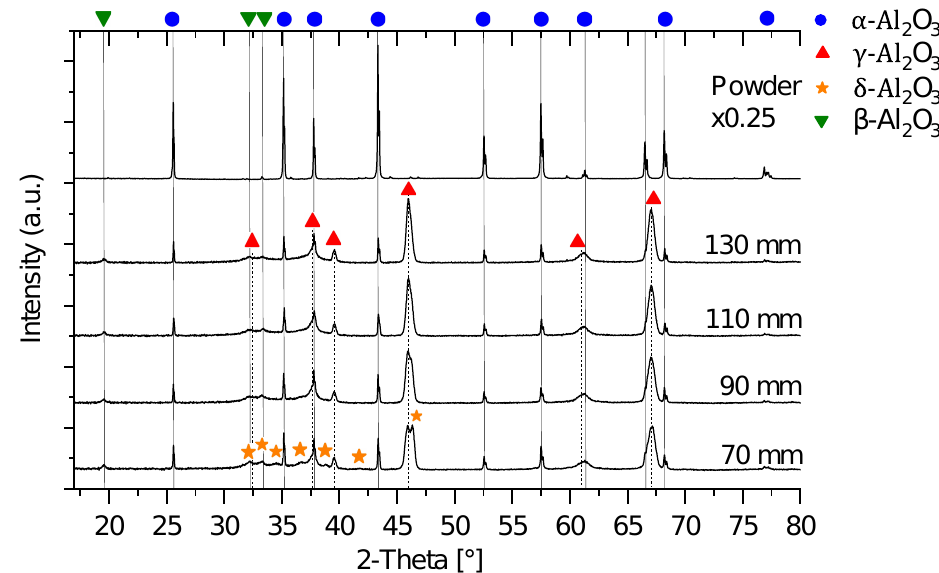
Figure 3. XRD analysis of the Al 2 O 3 feedstock powder (scaling factor of x0.25) and the deposited coatings at different spray